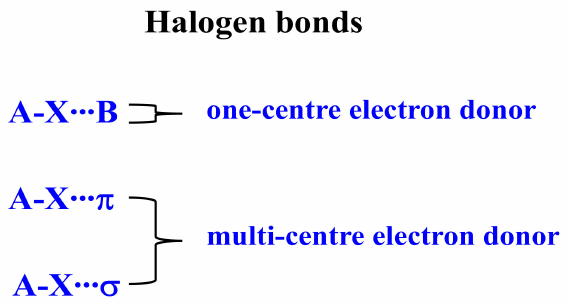
Scheme 1. Types of halogen